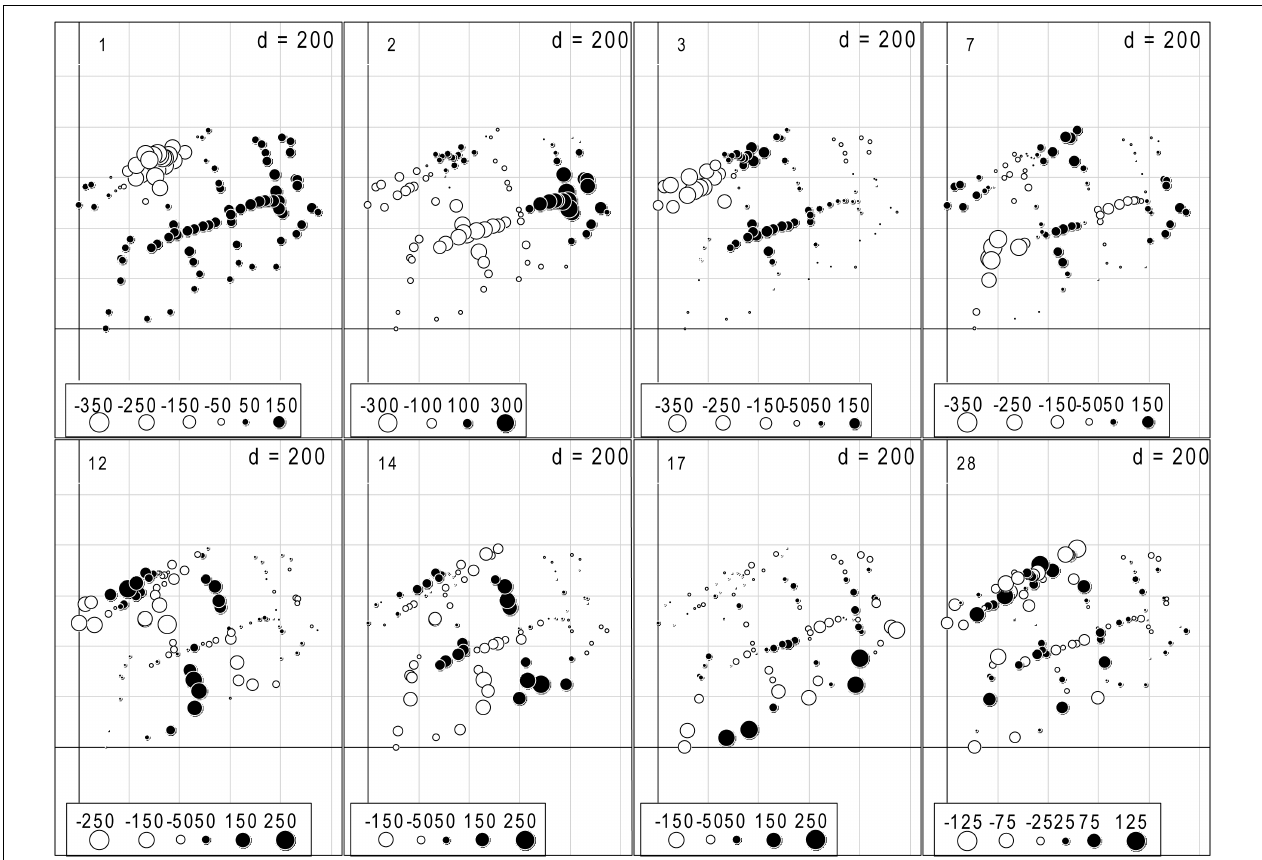
FIGURE 2 | The eight significant dbMEM variables with positive spatial correlation selected by the analysis of forward selection with Blanchet et al. (2008)’s double-stopping criterion, and alpha significant level and the adjusted R 2 ( R 2 adj ) of the global analysis were used as forward selection criterion (Blanchet et al., 2008; Astorga et al., 2011). The dots indicated the position and dbMEM value of each quadrat.